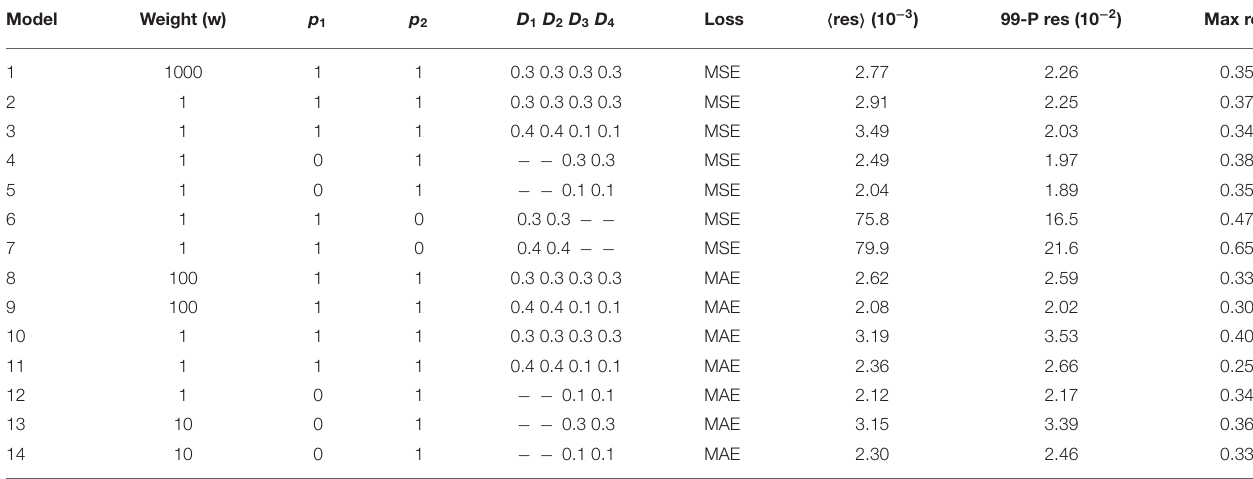
TABLE 2 | Trained models with their corresponding hyperparameters. Model